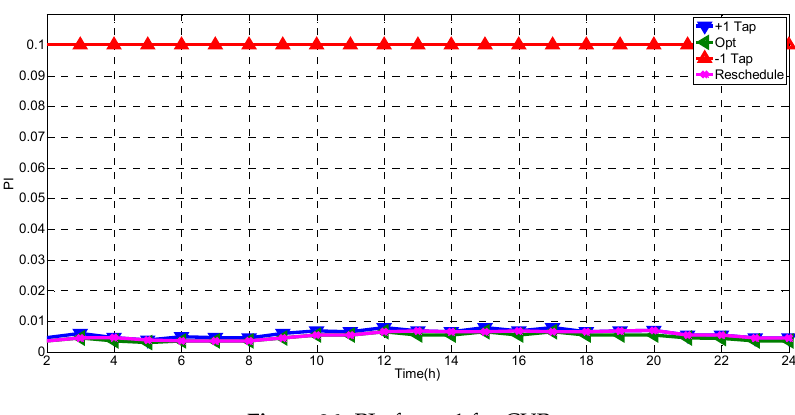
Figure 26. PI of case 1 for CVR.